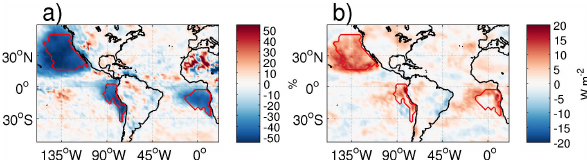
Fig. 6. (a) The relative difference in 5yr mean cloud-top cloud droplet number concentration between simulations geo-coag and geo-ref. (b) 5yr mean radiative flux perturbation between simula- tions geo-coag and geo-ref. Red values mean larger values in the geo-coag